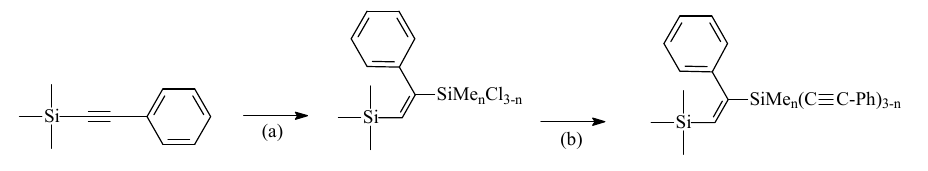
Figure 2. Limit generations for ethynylsilane dendrimers emanating from the (PhC ≡ C) core (left) and the (PhC ≡ C)